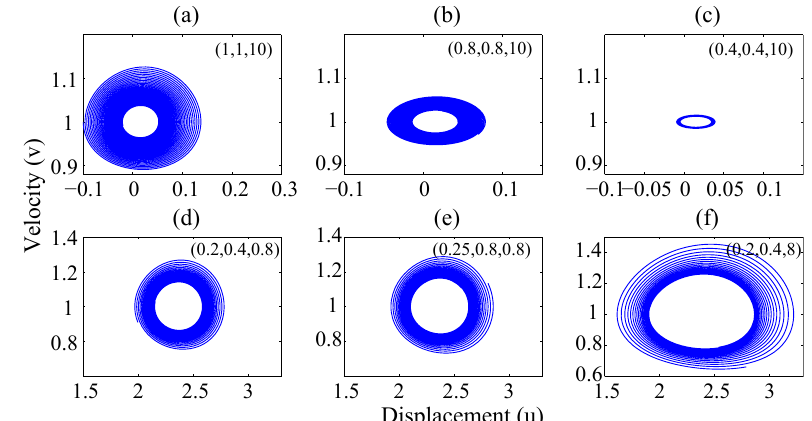
Figure 5. Unperturbed system τ(t) = 0. Projection of attractor onto the plane (u,v) . Panels (a) , (b) , and (c) have the position of equilibrium point u ∗ = η near zero for γ = 10, and ξ decreases as it is the range of u . Panels (d) , (e) , and (f) , for γ = 0 . 8, have both u ∗ and the range of values for u higher than (a) – (c)